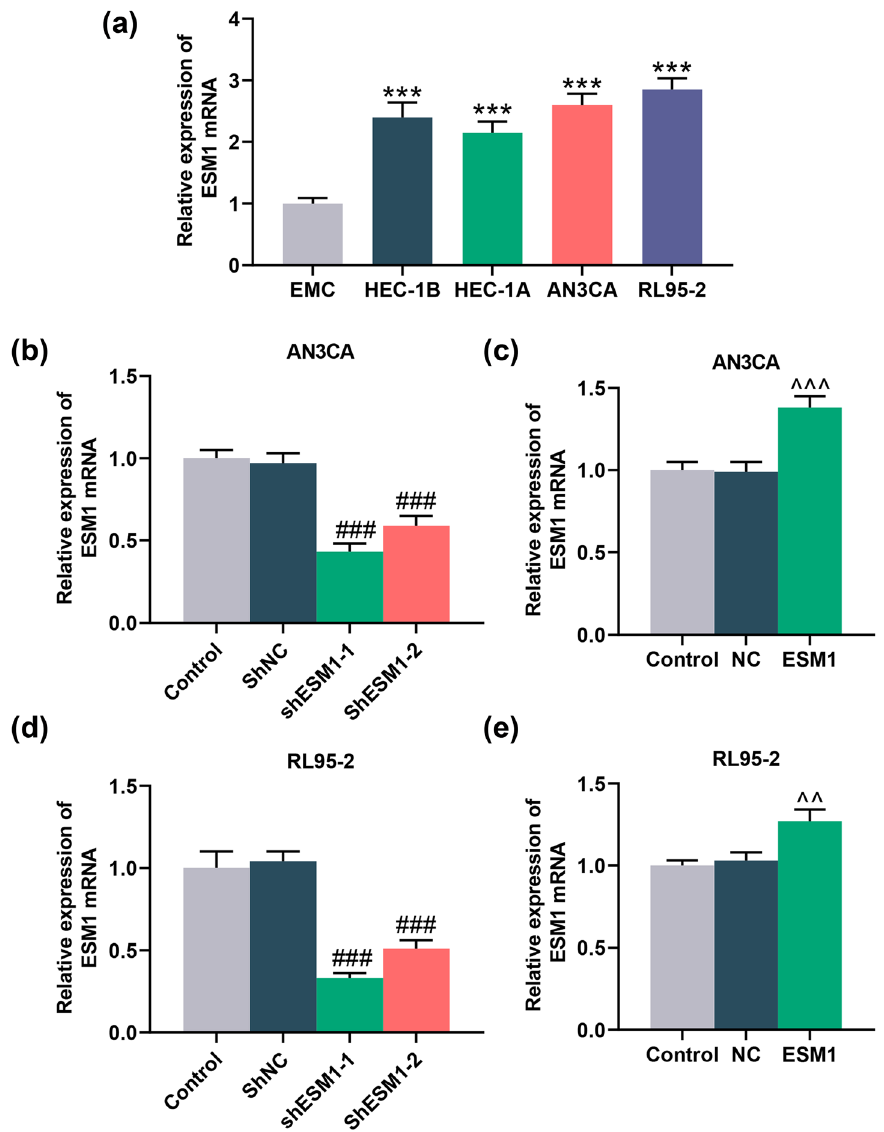
Figure 2: Expression of ESM1 in EC cells. ( a ) qRT - PCR was applied to quantify the expression of ESM1 in EMCs and EC cells ( HEC - 1B, HEC - 1A, AN3CA, and RL95 - 2 ) . ( b and c ) After AN3CA cells were transfected with shESM1 - 1, shESM1 - 2, or ESM1 overexpression plasmid, the level of ESM1 in AN3CA cells was determined by qRT - PCR. ( d and e ) After RL95 - 2 cells were transfected with shESM1 - 1, shESM1 - 2, or ESM1 overexpression plasmid, the level of ESM1 in RL95 - 2 cells was determined by qRT - PCR. GAPDH was applied as a standardized gene. *** P < 0.001 vs EMC; ### P < 0.001 vs short hairpin RNA - targeted negative control ( shNC ) ; ^^ P < 0.01, ^^^ P < 0.001 vs